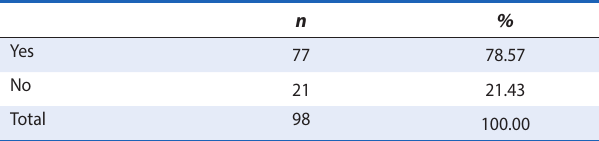
Table 2: Contraceptive use among the respondents